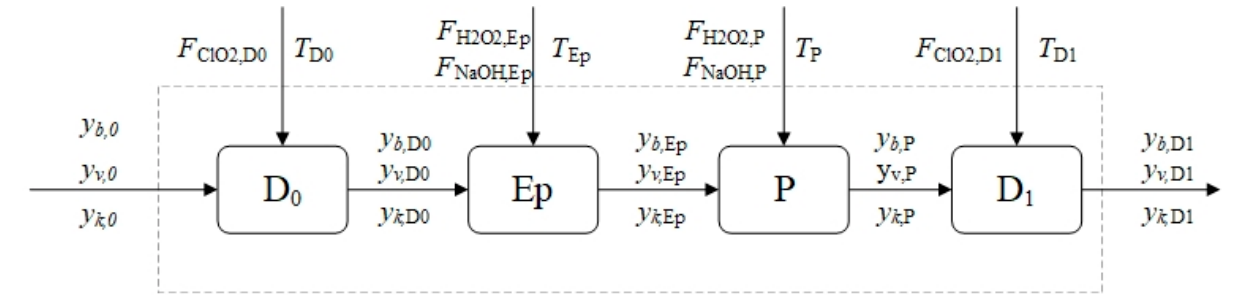
Figure 2. Bleaching process block diagram of pulp quality.